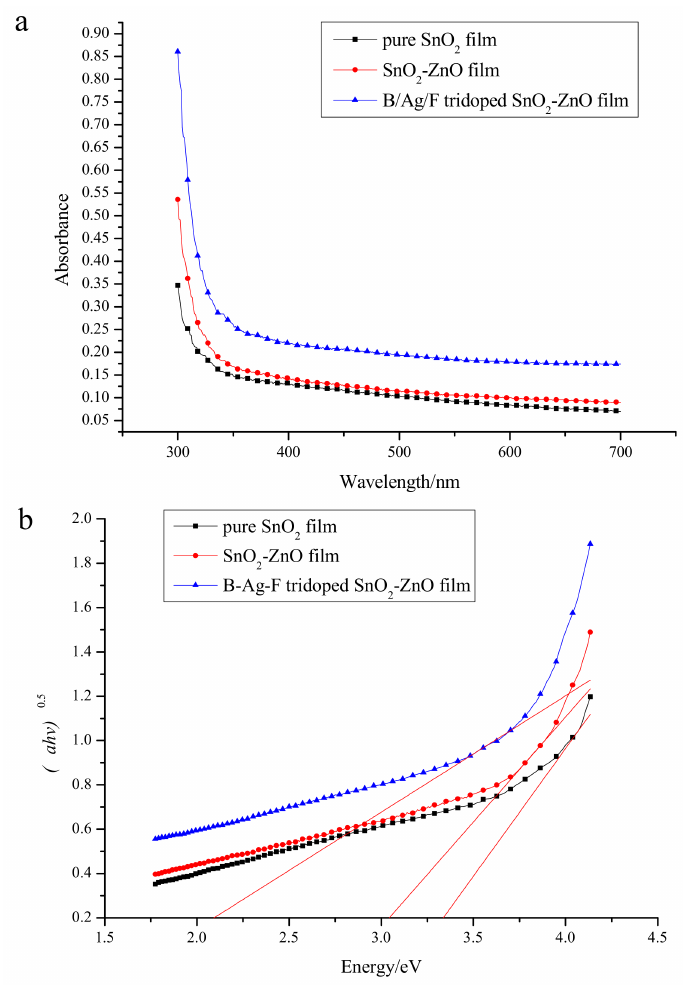
Figure 4. The ( a ) ultraviolet–visible absorption spectra and ( b ) ( α h ν ) 1/2 vs. h ν plots of SnO 2 , SnO 2 -ZnO, and B/Ag/F tridoped SnO 2 -ZnO